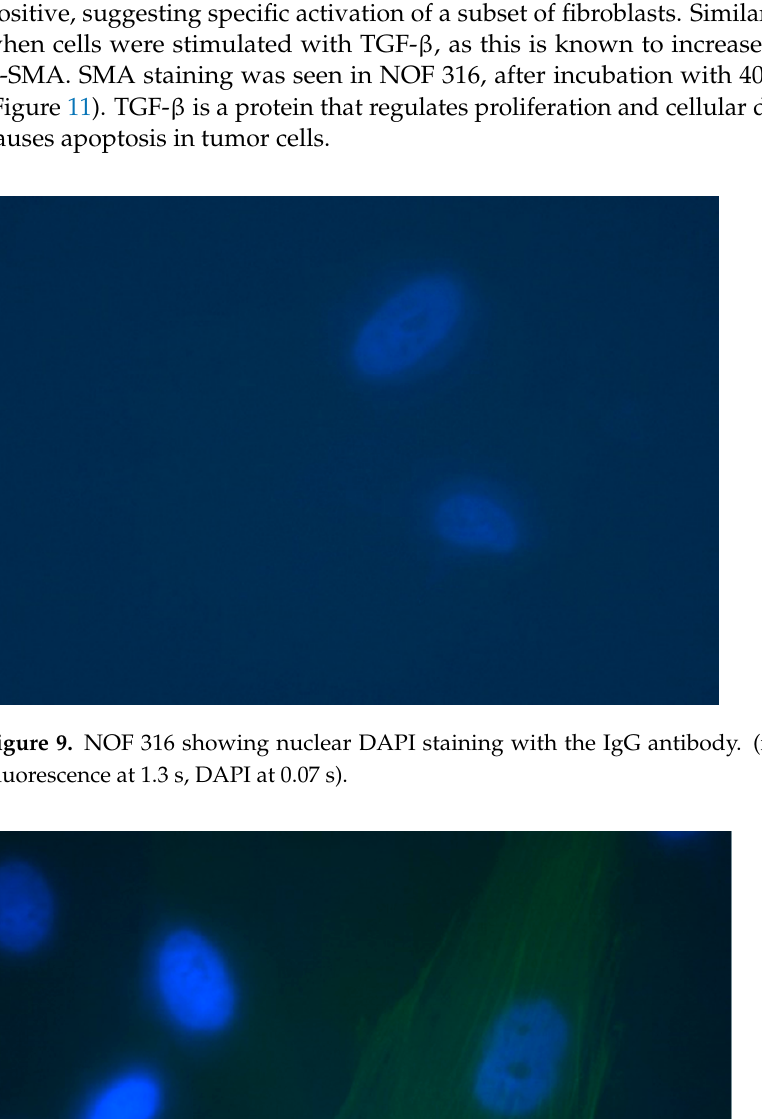
Figure 11. SMA expression in NOF 316 after incubation with 40 µg/mL of TGF β (magnification ×100, Fluorescence at 1.6 s, DAPI at 0.100 s). 4. Discussion The present study was based on the hypothesis that Khat is cytotoxic to NOFs and SSC4 cells. It was also hypothesized that Khat would stimulate positive expression of α -SMA in fibroblasts. Interestingly, the study revealed the cytotoxicity of Khat for both NOFs and SSC4 cells, and increased cell death occurred as compared to the negative control. Moreover, fibroblasts also stained positive for α -SMA after Khat exposure. Therefore, both postulated hypotheses were accepted. For cytotoxicity assessment, MTT assay was employed, as the technique was convenient, rapid, and reproducible [17]. Similarly, immunofluorescence was used to determine α -SMA positive staining in fibro- blastic cells, as it showed high sensitivity and specificity over other techniques [18]. Khat was studied in relation to its damaging effects on oral mucosal keratinocytes, but its potential influence on the oral fibroblasts and cancer cell line was not studied. Multiple studies stated that Khat chewing is associated with oral hyperplasia, hyper- keratinization, and oral cancers [19]. The results of the present study showed that Khat caused cell death of both NOFs and SCC4 cells. The exact mechanism for Khat-induced cell death is not known. However, the available literature focused on the presence of al- kaloids (cathine and other phytochemicals) as a cause of its cytotoxicity and suggests that Khat could induce cell death even in short tissue exposure [6]. In addition, Khat also triggers intracellular generation of free radical, i.e., reactive oxygen species (ROS) and Glutathione (GSH) depletion, which initiates programmed cell death (apoptosis) by causing injury to the DNA [20]. Furthermore, in the present study, it was also observed that higher concentrations (25 mg/mL) of Khat displayed variable outcomes of cytotoxi- city, not showing significant cell death of NOF 316 cells, as compared to the other tested cells.